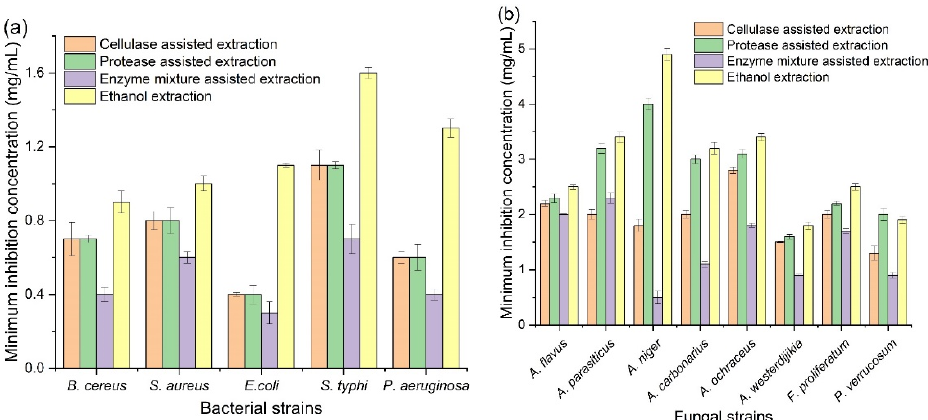
Figure 2. Minimum inhibitory concentrations of corn tassel extracts by different extraction methods against food-borne pathogenic bacteria ( a ) and mycotoxigenic fungi ( b ).